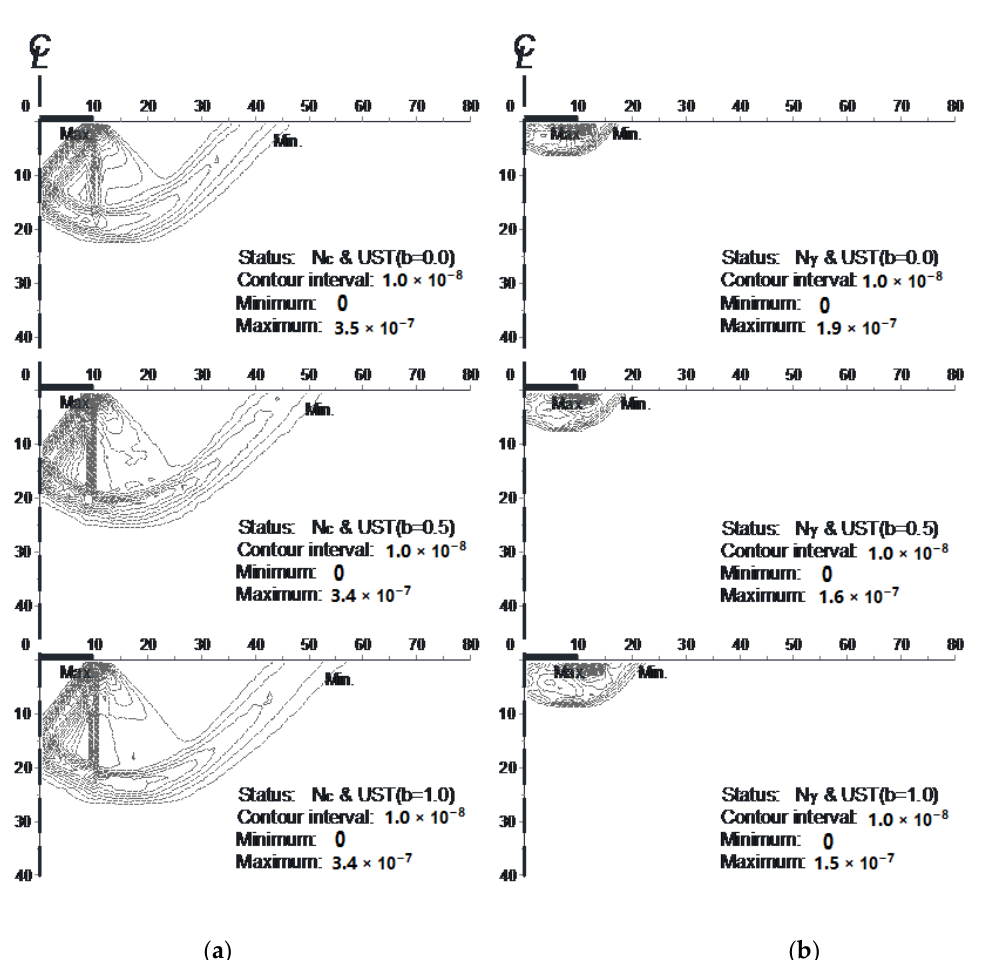
Figure 9. Isolines of maximum shear strain rate of foundation beneath strip footing under ultimate state: ( a ) N c , ( b ) N γ .